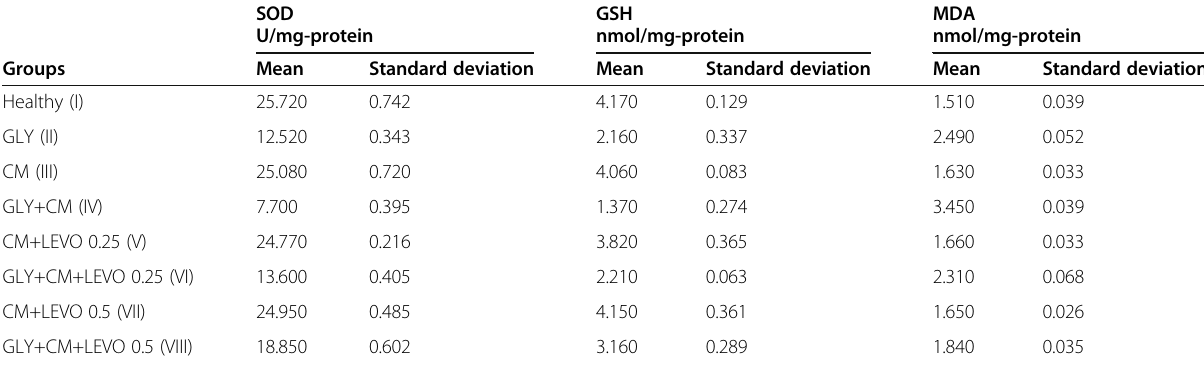
Table 2 The mean superoxide dismutase (SOD) activity, glutathione (GSH), and malondialdehyde (MDA) levels according to experimental groups